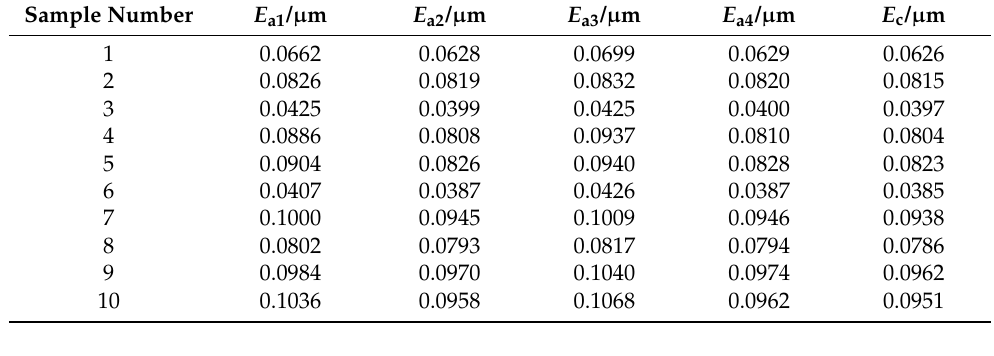
Table 4. Roundness error calculation results of different methods.